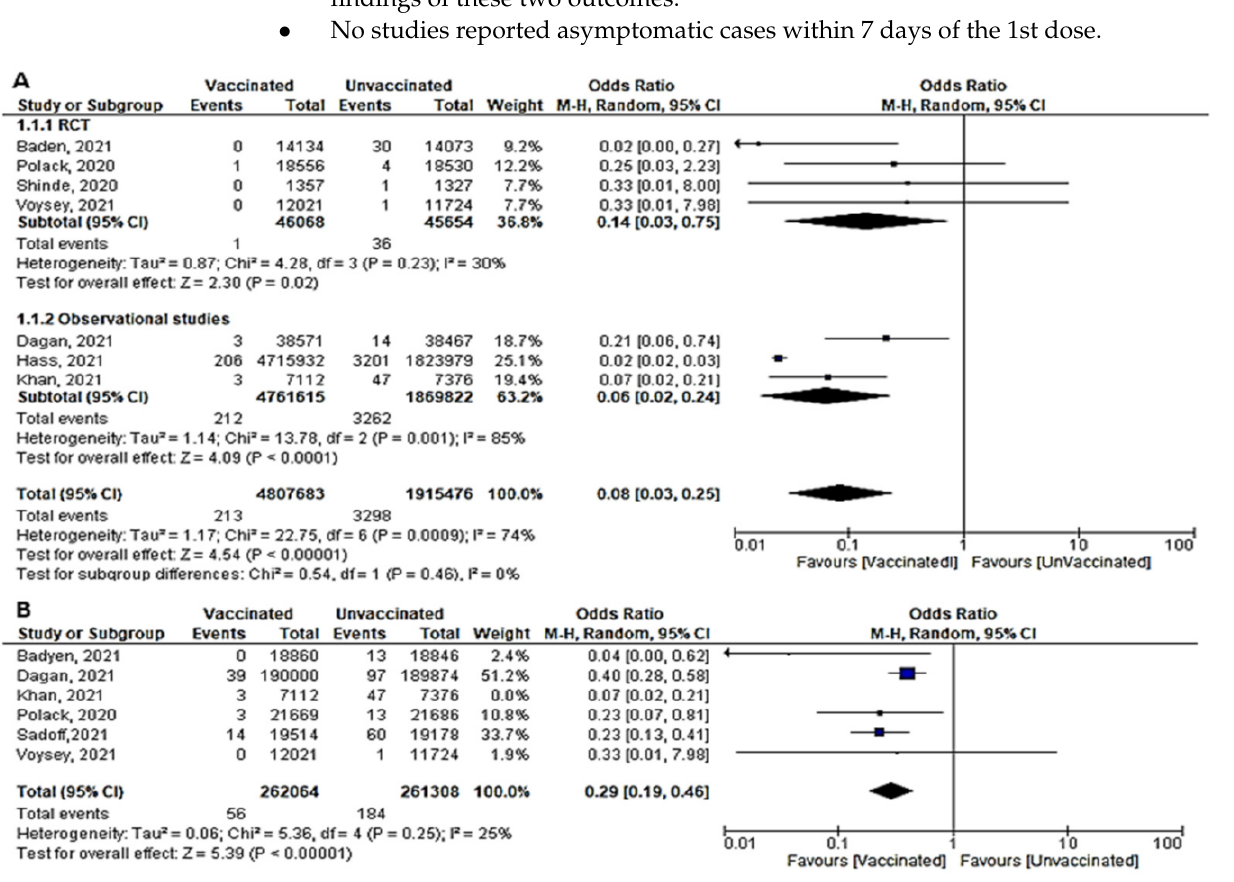
Figure 5. ( A ) Severe COVID-19 infection 7 days after 2nd dose of vaccination. ( B ) Severe COVID-19 infection 7 days after 1st dose of